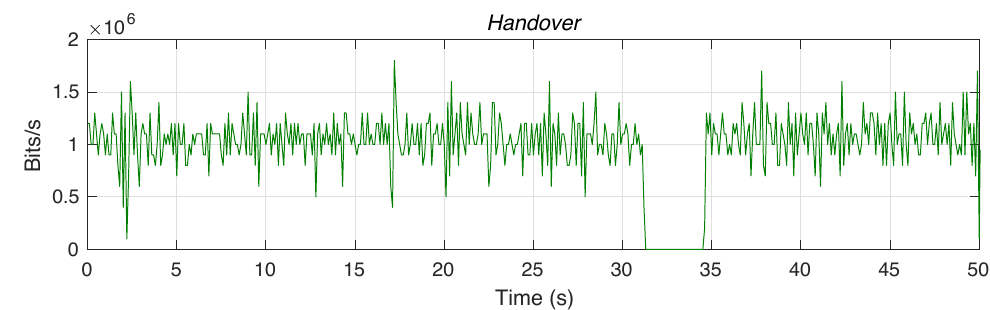
Figure 5. Interruption of the reception of real-time video due to